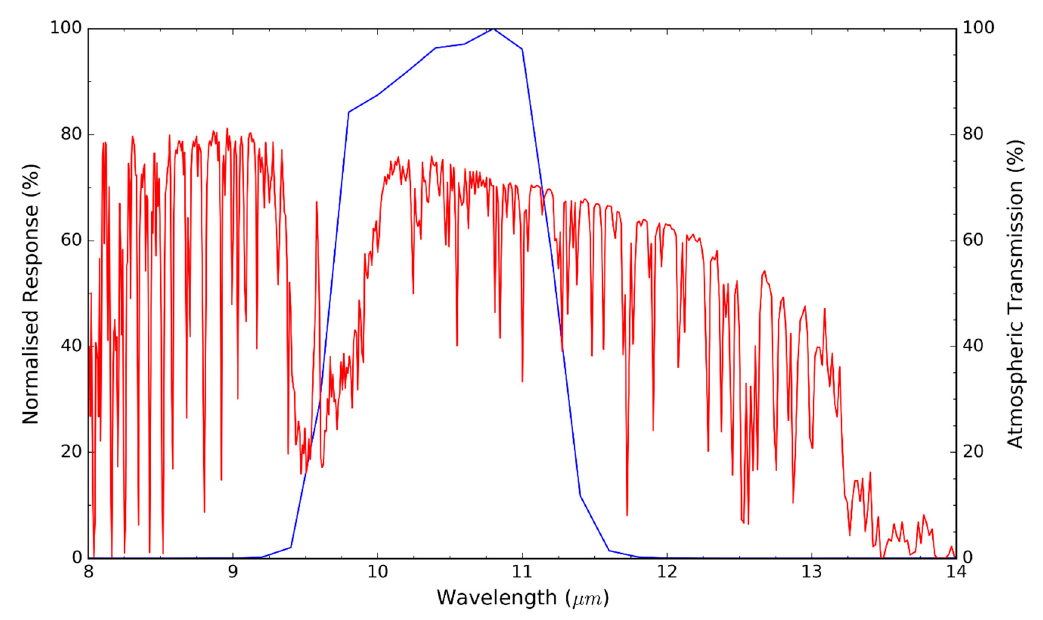
Figure 4. Spectral response function of the Heitronics KT15.85 radiometer (blue, left axis) overplotted on the atmospheric transmission of a standard mid-latitude summer atmosphere (red, right axis) calculated using MODTRAN 5.0 [61].